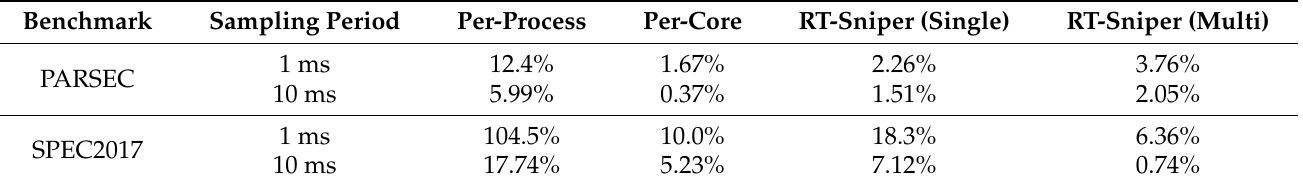
Table 1. Overhead of SPEC and PARSEC ( 1 ) execution time according to HPC collection strategies. (1) streamcluster and netstreamcluster are excluded since the execution time is inconsistent due to frequent synchronizations [41].